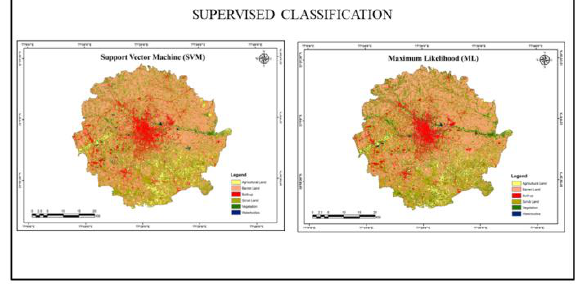
Figure 3. Supervised Classification